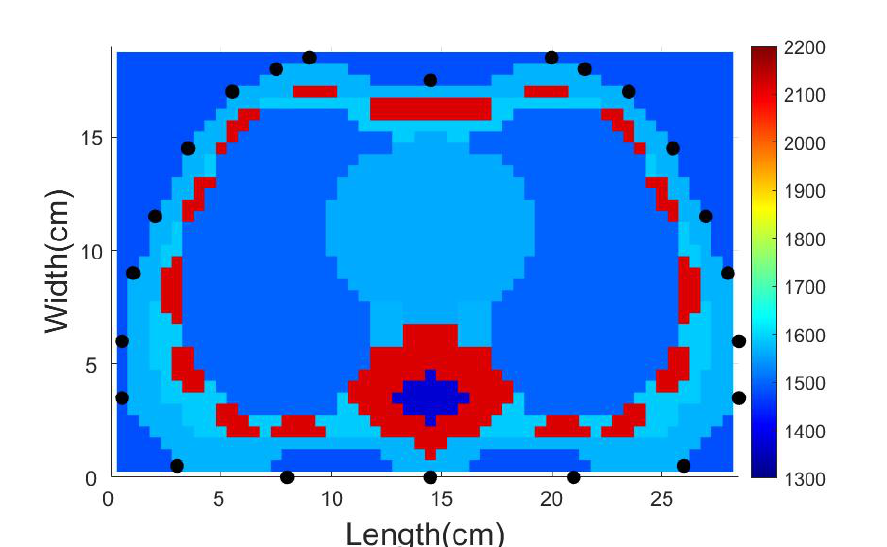
Figure 2. The thorax model in [55], containing lung, heart, rib, spine, etc. It is 28.5 cm in length and 19 cm in width. The blue background is set to be water. The black points around the thorax are where the transducers placed. The transducer is labeled counterclockwise and the top-middle transducer is the No. 1 transducer.